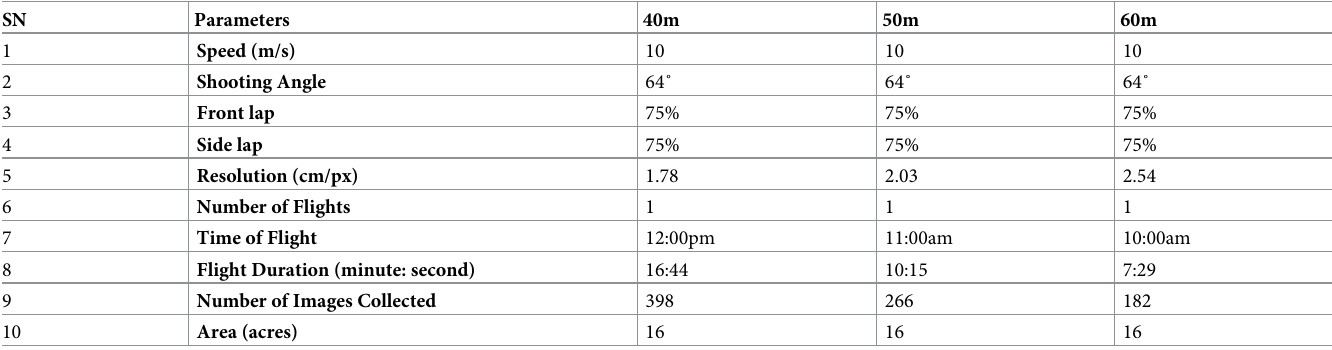
Table 1. Flight details for multiple flight